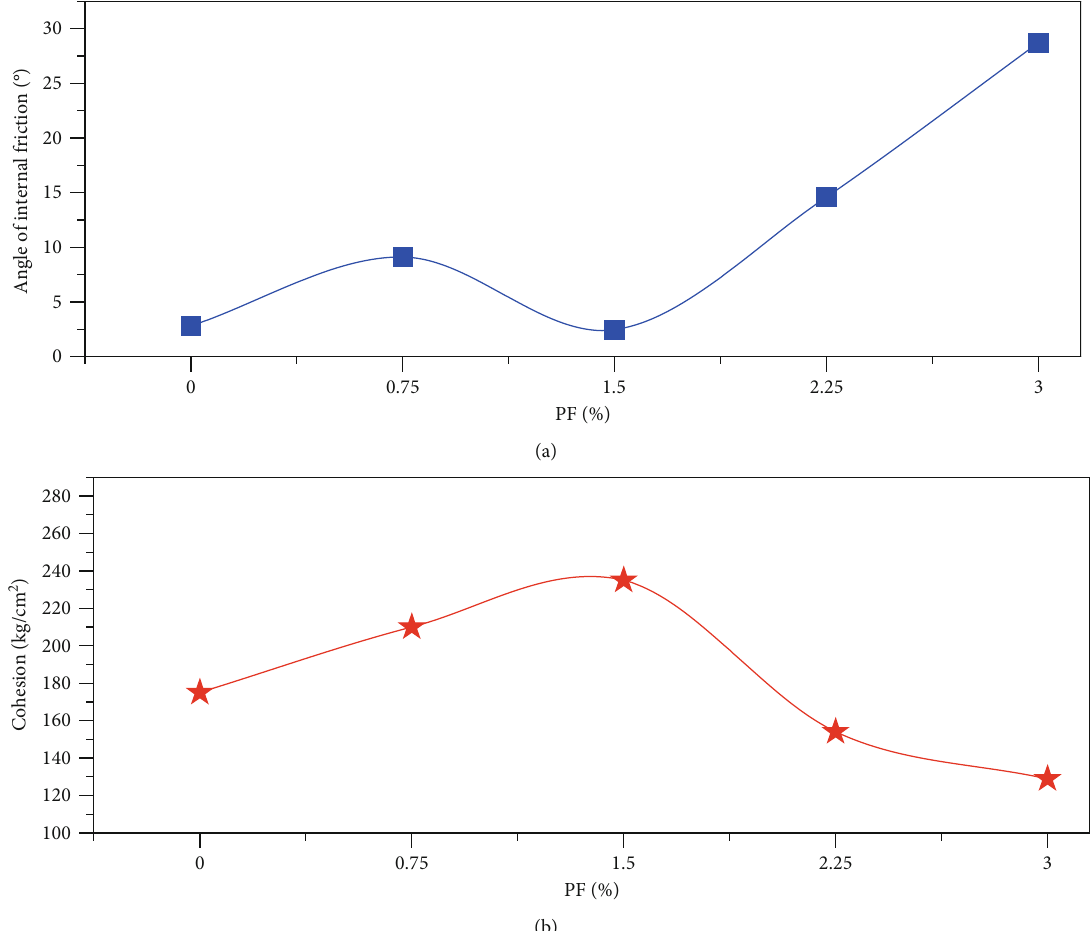
Figure 6: Relationship between PF content and shear strength parameters (a) angle of internal friction and (b)